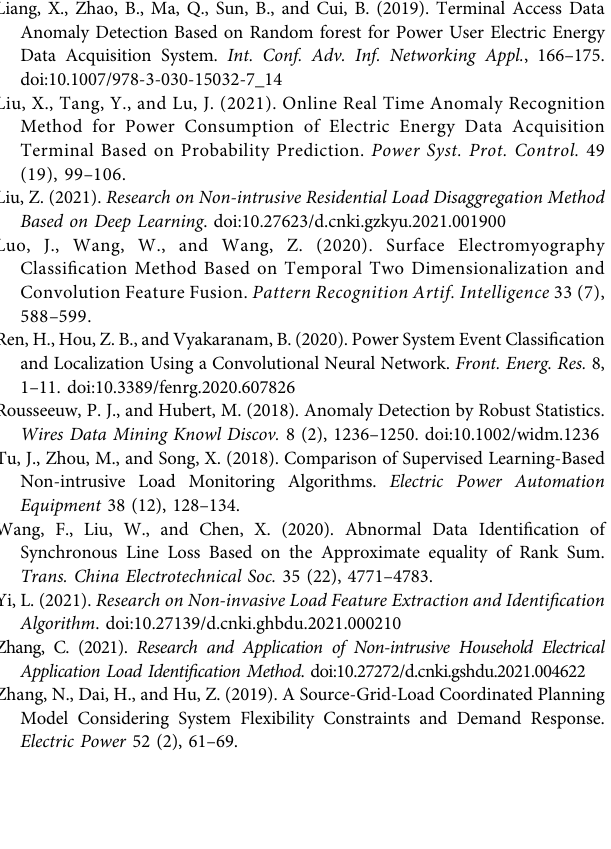
Algorithm . doi:10.27139/d.cnki.ghbdu.2021.000210 Zhang, C. (2021). Research and Application of Non-intrusive Household